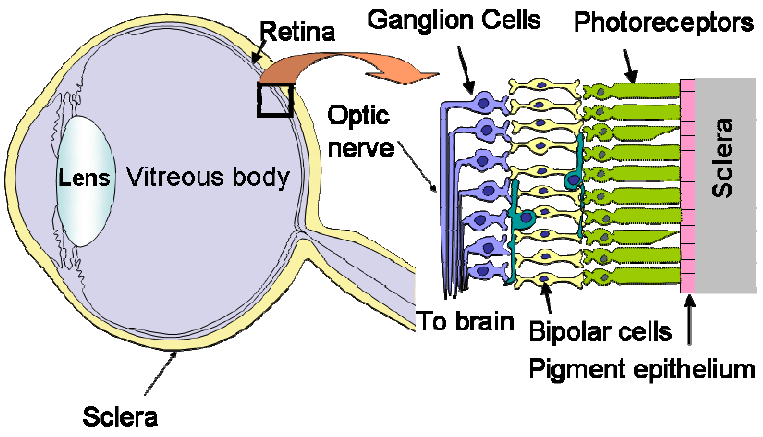
Figure 3. Schematic illustration of the structure of the eye and